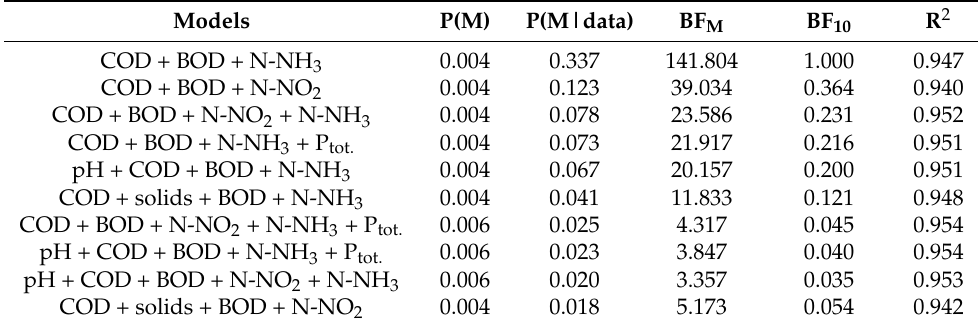
Table 9. The Bayesian linear regression model.